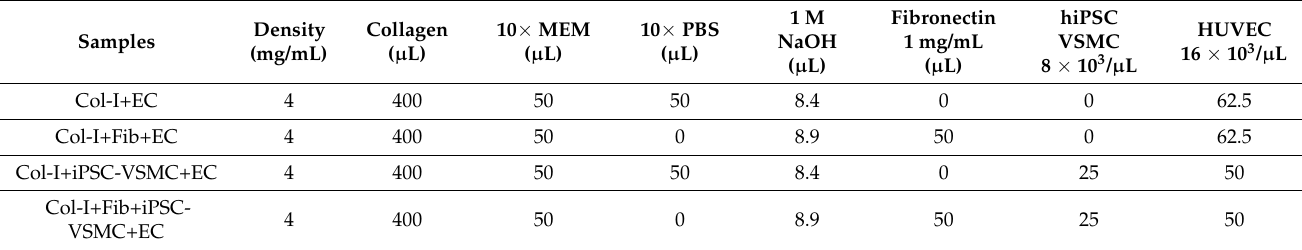
Table 1. Various formulations of collagen + fibronectin hydrogels with hiPSC-VSMCs and HUVECs in a total volume of 500 µ